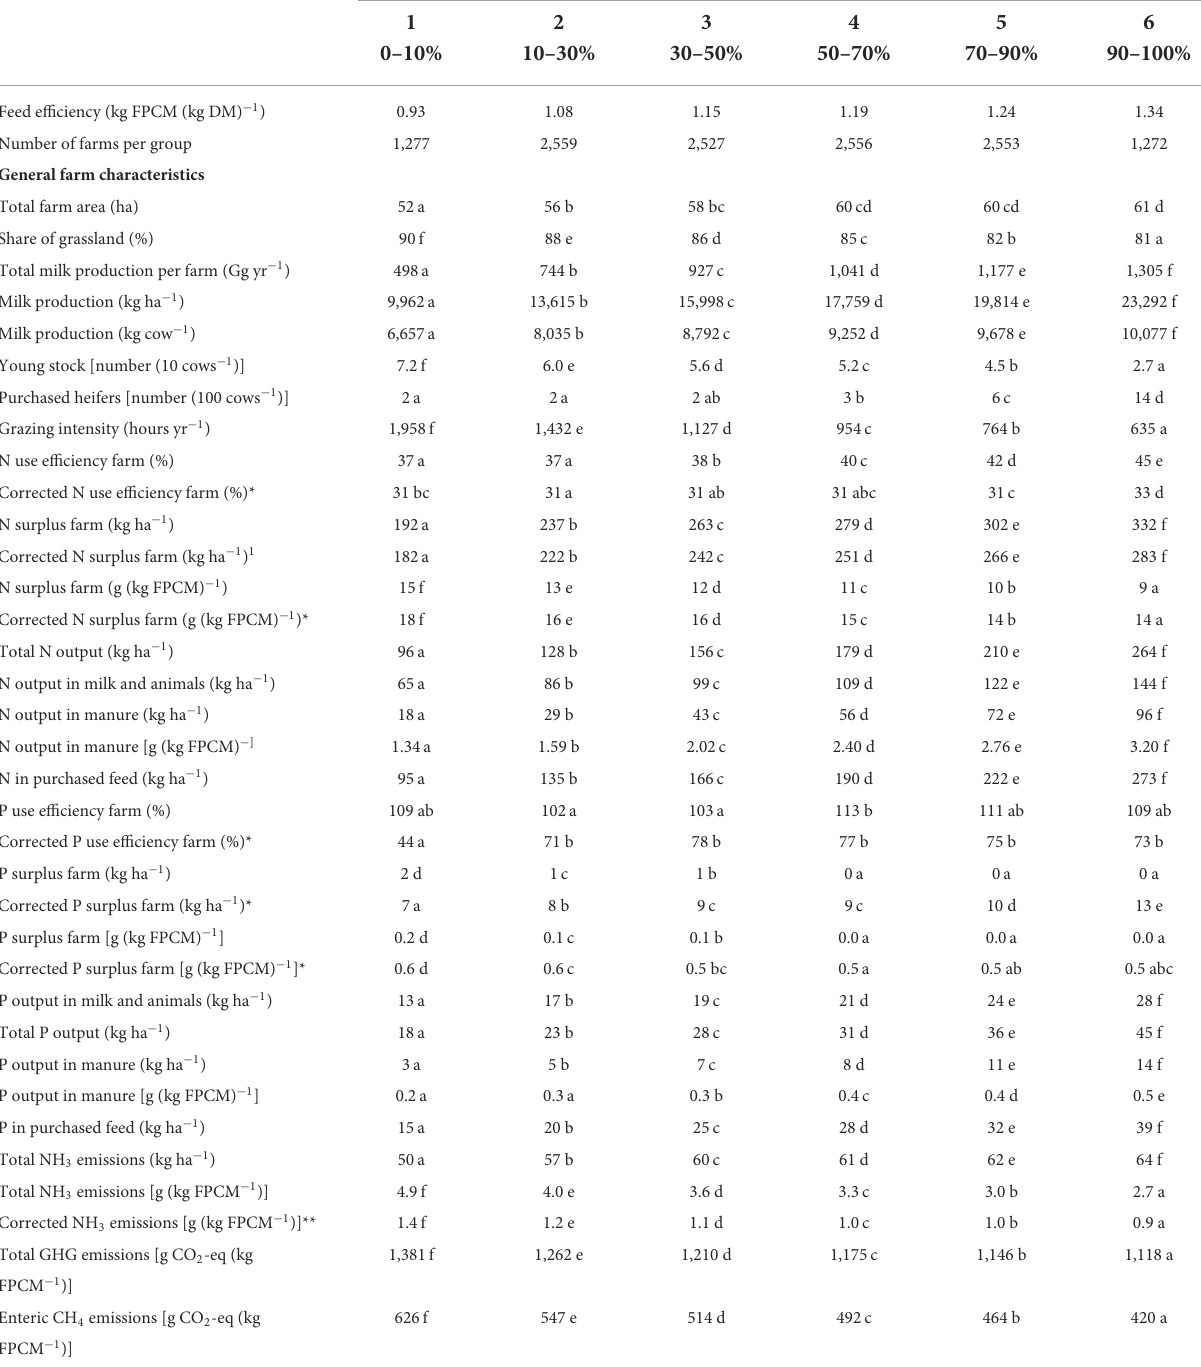
TABLE 1 Mean farm characteristics and indicators of 12,770 dairy farms for the year 2020.